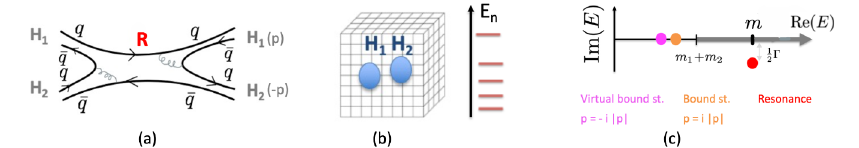
Figure 1. Extracting resonances and near-threshold bound states from one-channel scattering.